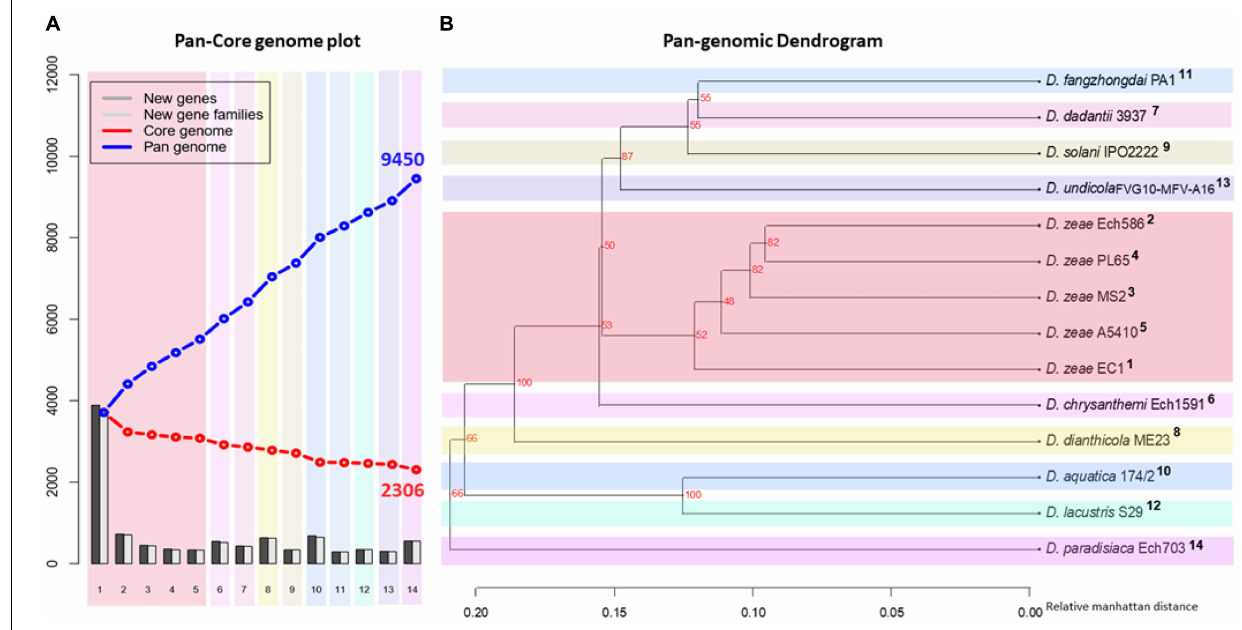
FIGURE 4 | Pan- and core-genome analyses among the Dickeya species. Pan- and core-genome plot: (A) The pan and core genome analyses were developed by employing BLAST with a cutoff of 50% identity and 50% coverage of the longest gene. (B) Pan-genome tree: the respective dendrogram illustrates the grouping of species based upon the shared gene families (core genome) defined in the pan- and core-genome analysis. Organisms are marked 1–14; 1, PL65; 2, A5410; 3, MS2; 4, Ech586; 5, EC1 ( D. zeae ); 6, D. undicola FVG10-MFV-A16; 7, D. aquatica 174/2; 8, D. lacustris S29; 9, D. solani IPO 2222; 10, D. dadantii 3937; 11, D. dianthicola ME23; 12, D. fangzhongdai PA1; 13, D. paradisiaca Ech703; and 14, D. chrysanthemi